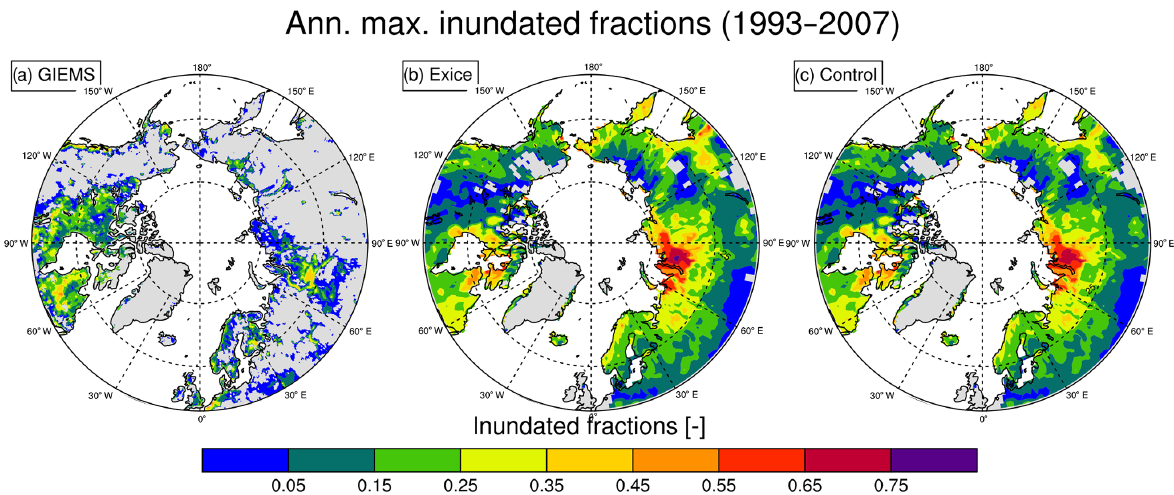
Figure 6. Surface water fraction comparison from high-latitude ( > 50 ◦ N) maps of annual maximum surface wetlands from the GIEMS dataset (Prigent et al., 2012) and annual maximum f h2osfc values of the Exice and Control experiments for the period